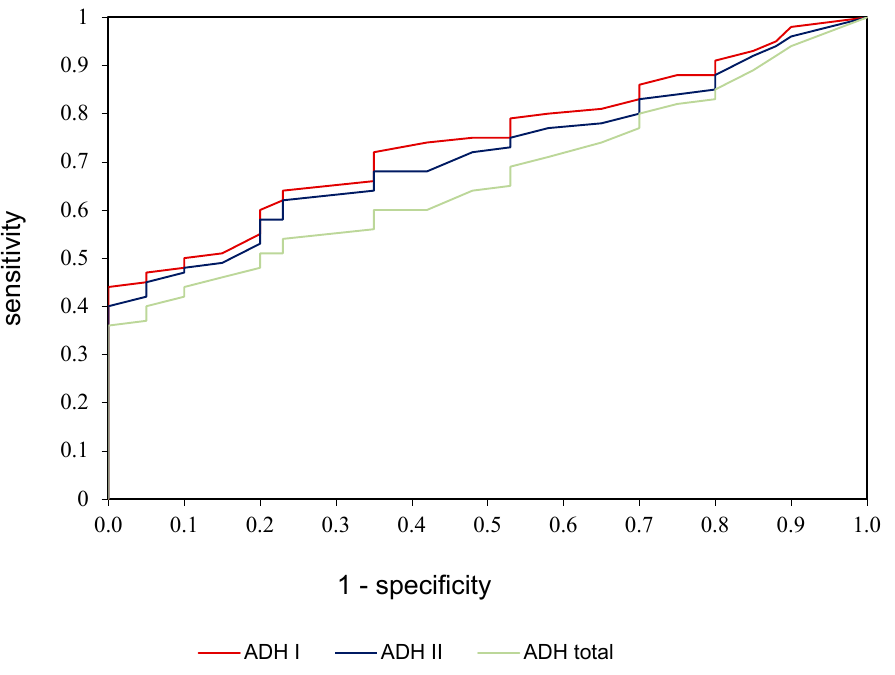
Figure 3. ROC analysis of ADH I, ADH II, and ADH total in patients with alcoholic fatty liver compared to control group.